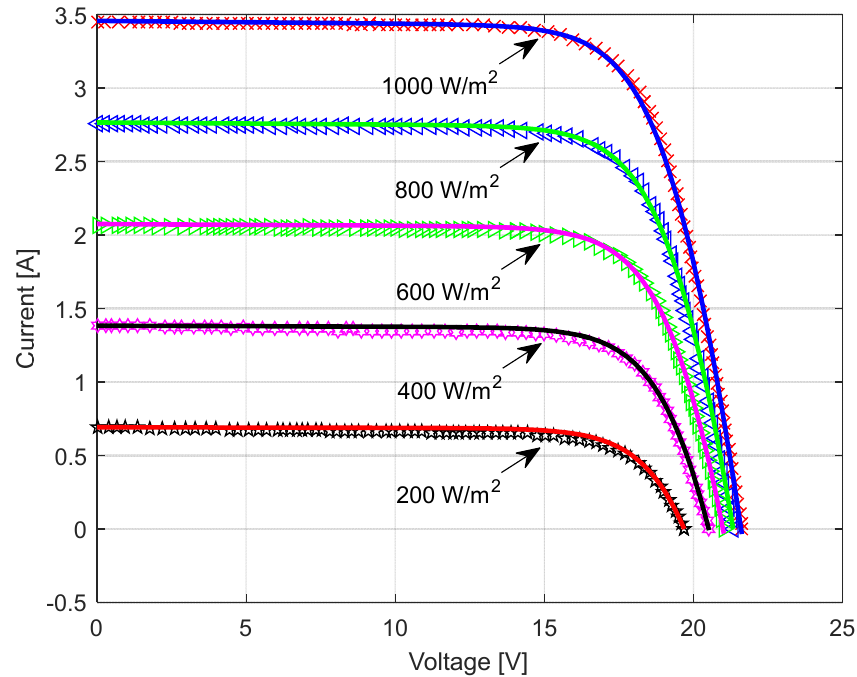
Figure 16. Current-voltage characteristics at 25 °C for different irradiance levels.